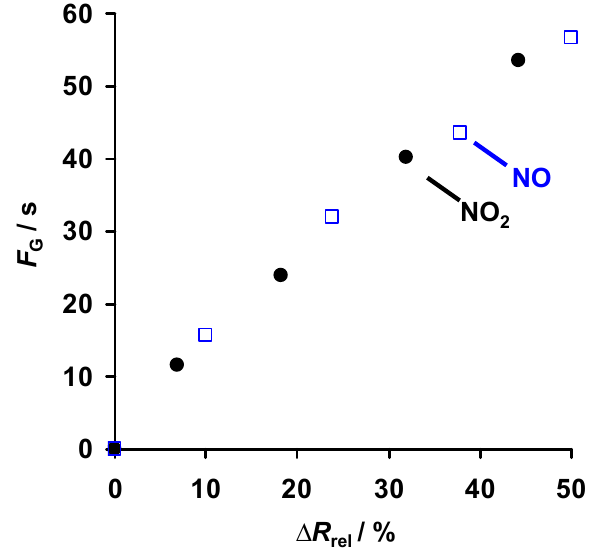
Figure 13. Correlation between electrical responses ∆ R (upon regeneration) affected by NO